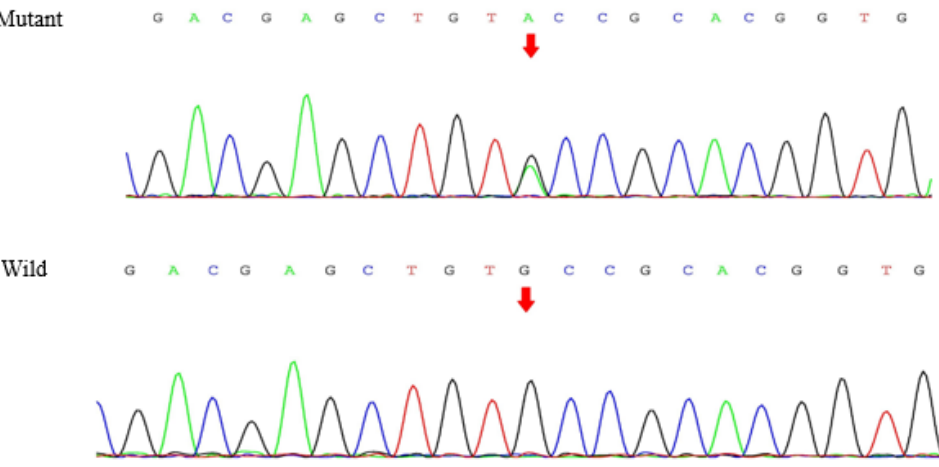
Figure 3. Sanger sequencing identified the mutation in RET .